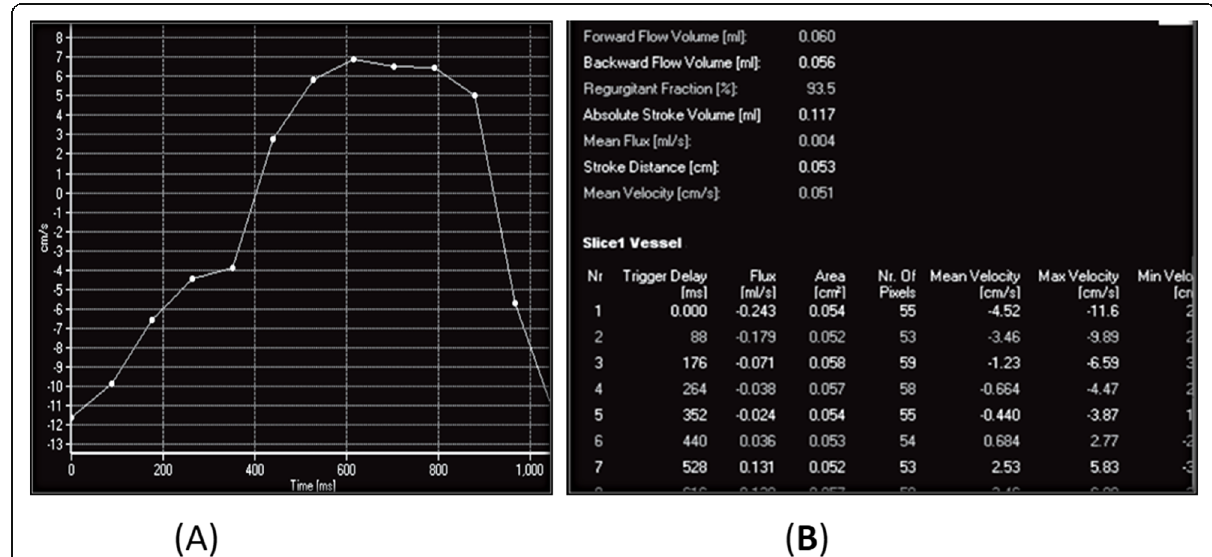
Fig. 1 a Maximum velocity-time graph following ROI placement on the cerebral aqueduct in phase-contrast images obtained [positive values (diastolic) show CSF flow velocity in the caudocranial direction and negative values (systolic) CSF flow velocity in the craniocaudal direction]. b CSF flow data [stroke volume (ml), forward flow volume (ml), backward flow volume (ml), regurgitant fraction (%), absolute stroke volume (ml),